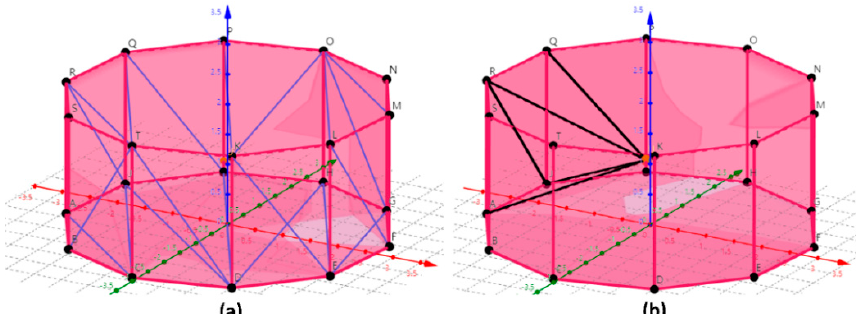
Figure 8. Volume of the polyhedron was calculated with a triangular pyramid as the minimum unit. ( a ) final polyhedron; ( b ) minimum unit in the volume calculation process was a triangular pyramid. The black line represents the edges of the triangular pyramid.